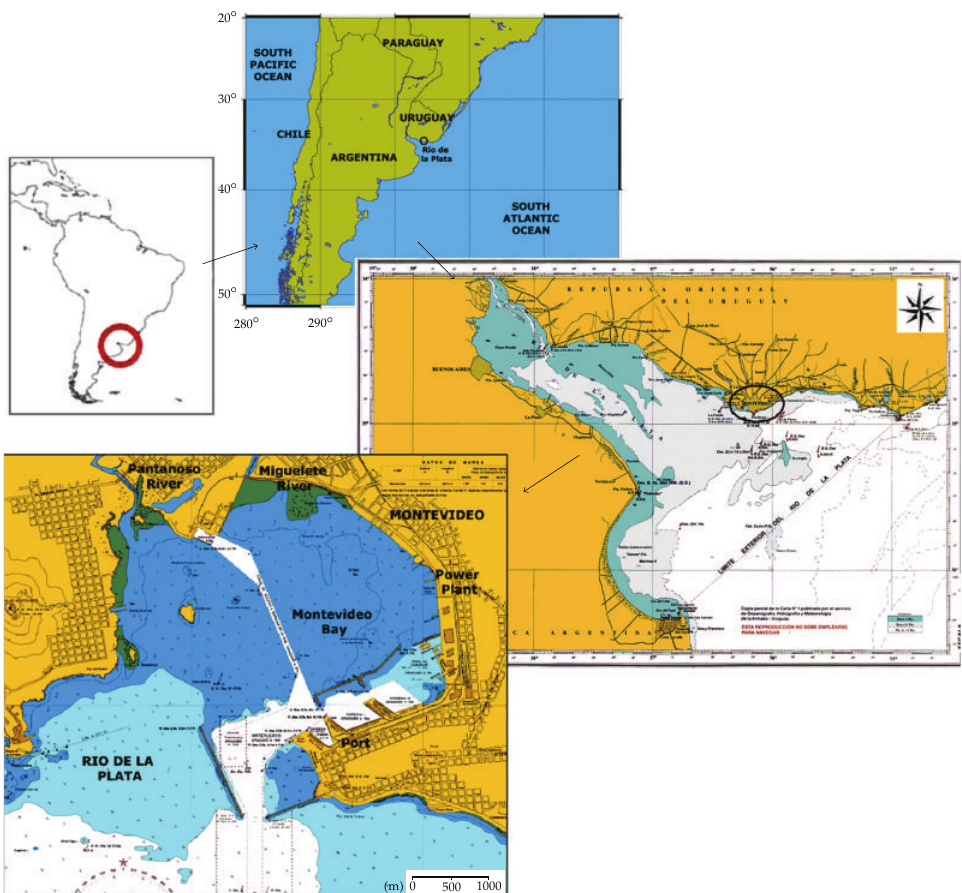
Figure 1: Study area